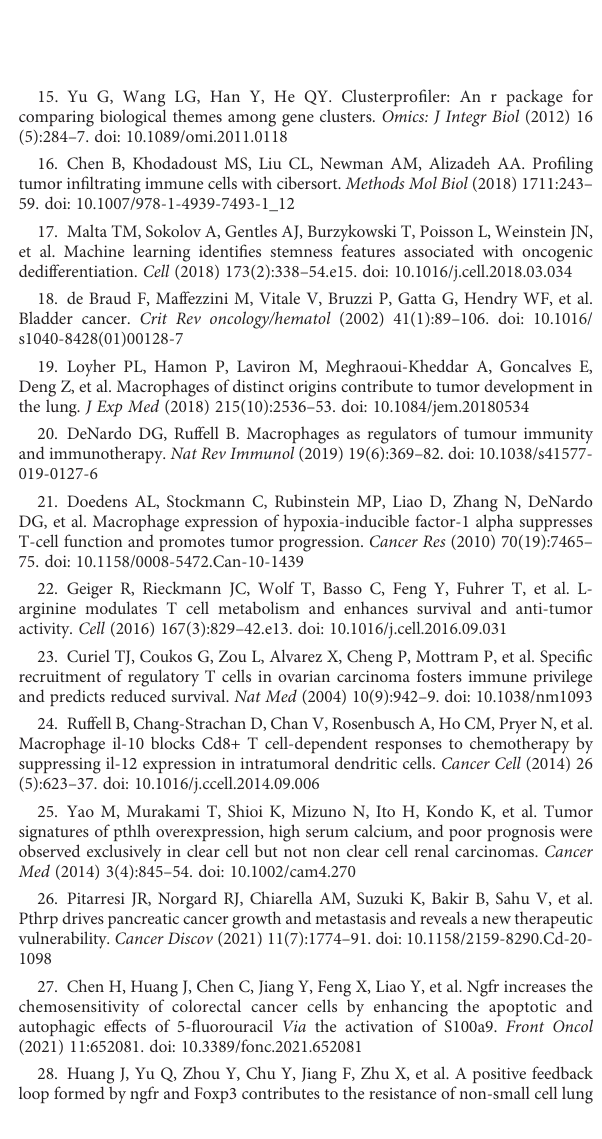
SUPPLEMENTARY FIGURE 5 Knockdown ef fi ciency of